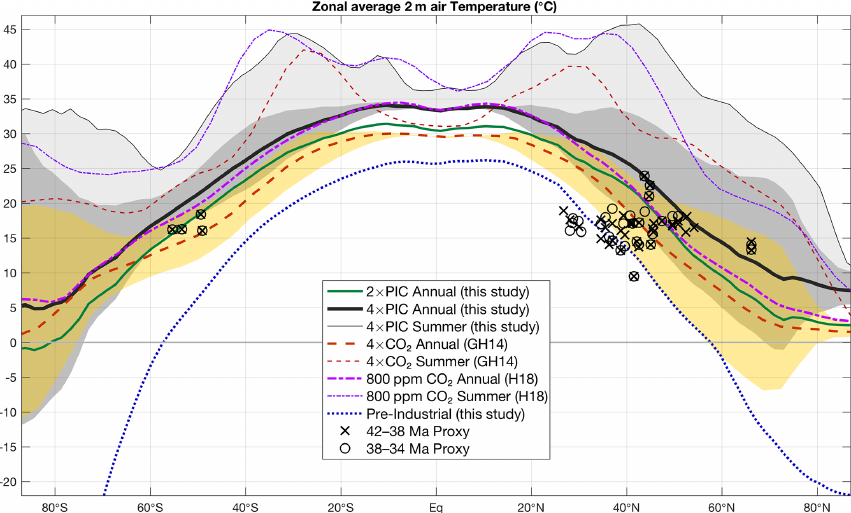
Figure 8. Annual mean zonal average near-surface (2m) air temperature for the 38Ma 4 × PIC (black; this study), 2 × PIC (green; this study), 45Ma 4 × CO 2 (dashed red; GH14 – Goldner et al., 2014), 38Ma 2 × CO 2 (i.e. 800ppm, dash-dotted magenta; H18 – Hutchinson et al., 2018), and pre-industrial reference (dotted blue; this study) simulations. Estimates from proxy data are represented by crosses for 42–38Ma and circles for the 38–34Ma period. Shading indicates the seasonal (DJF, JJA) range in temperatures for both the 38Ma 4 × PIC (grey) and 45Ma 4 × CO 2 (yellow) case; thin lines show the highest summer temperatures at each latitude (light grey shading added for 38Ma 4 ×